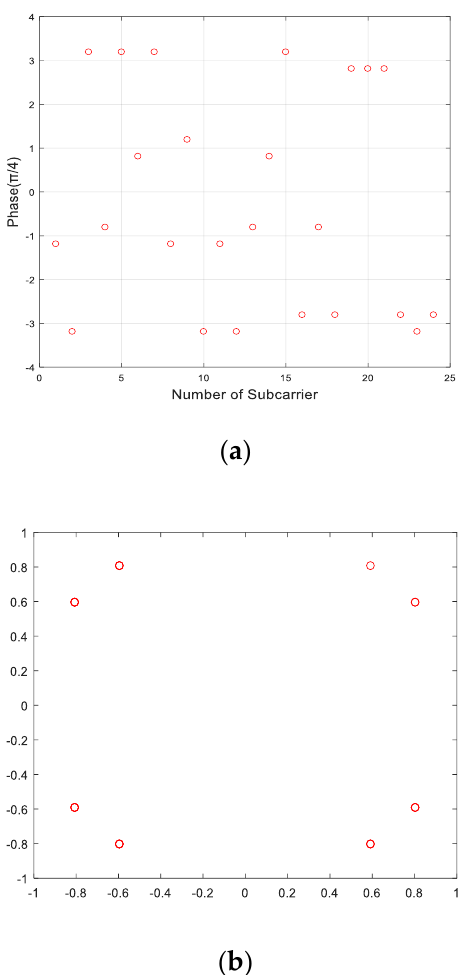
Figure 4. Demodulated phase of DMRS. ( a ) Phase of DMRS. ( b ) Constellation of DMRS.